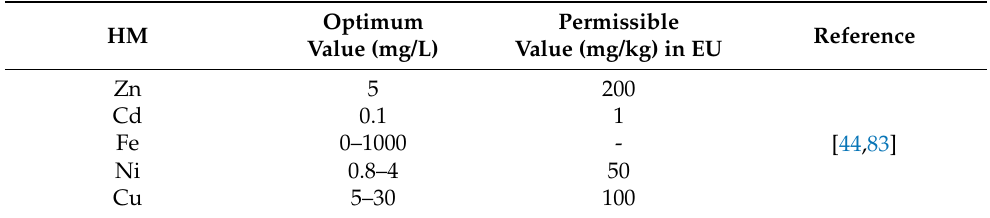
Table 4. Optimum values of heavy metals (HMs) for efficient anaerobic digestion (AD) and permissi- ble values of HMs for use of fertilizer in